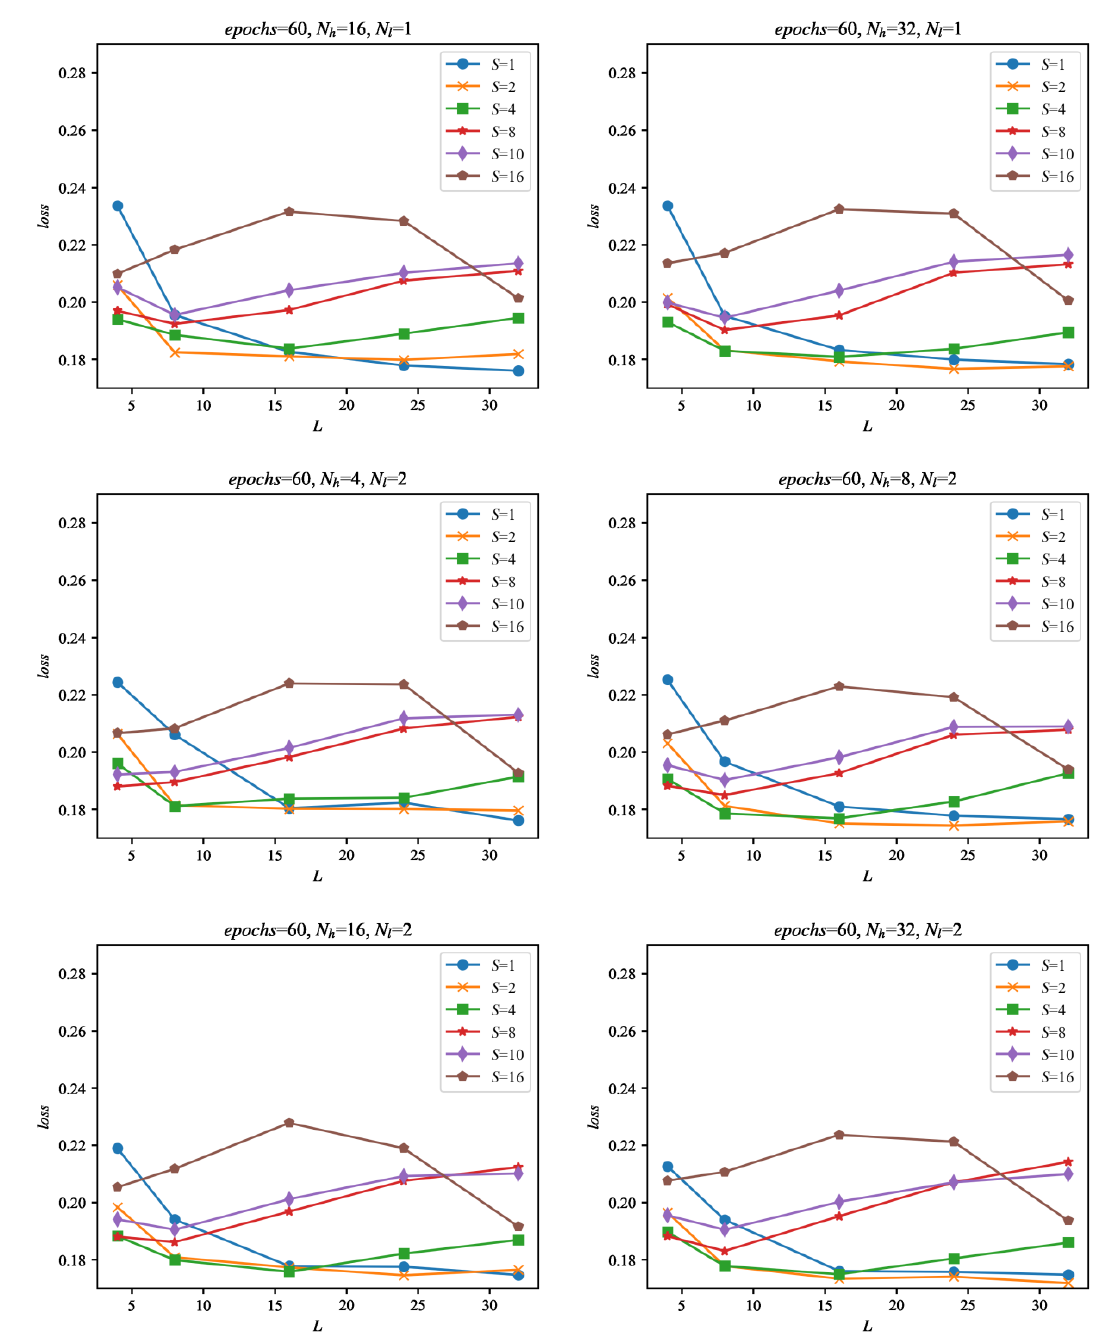
Figure 10. Evaluation of the networks during training as a function of the length of the input sequences L . The evaluation was made using the set of 29 evaluation signals, not used for training, for all of the configurations of the networks considered in this paper. The loss is calculated as an average evaluation loss of all evaluation signals. For the loss values on vertical axes in the graphs, the best evaluation loss found after the given number of epochs was used. The same data but with the loss presented as a function of number of neurons in hidden layer N h are presented in Figure 11.